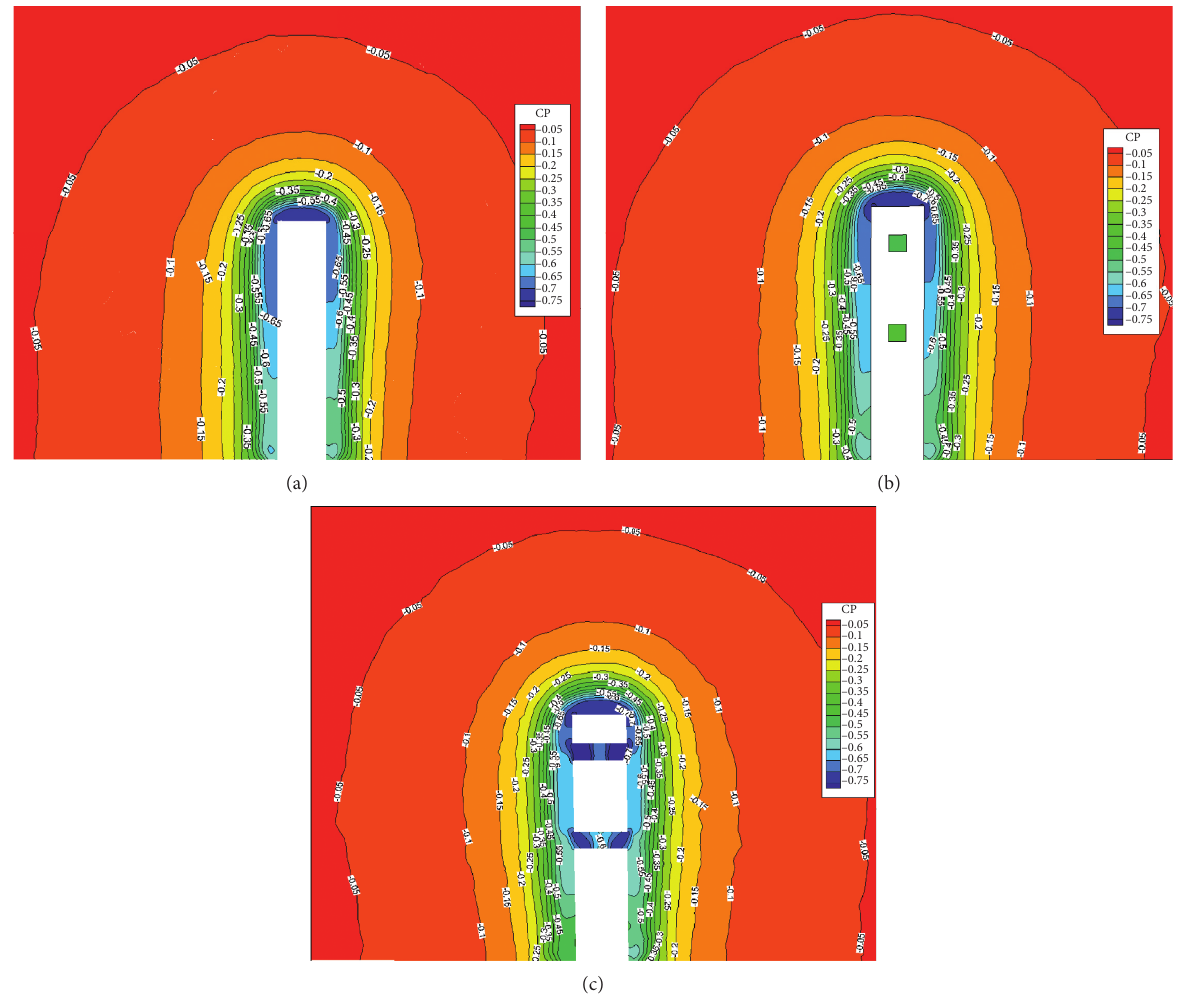
Figure 9: Mean wind pressure distributions on side faces at different elevations. (a) L-1 model. (b) L-2 model. (c) L-3